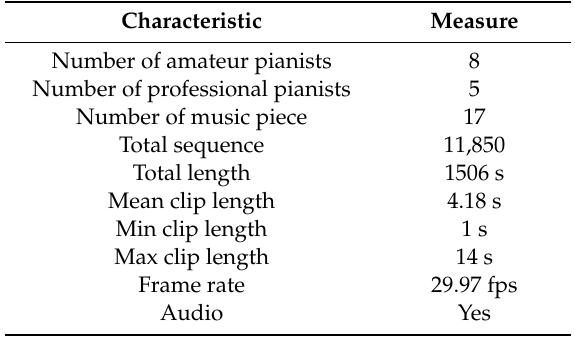
Table 1. Characteristics of Classic Piano Performance Postures of Amateur and Professionals (C3Pap) dataset.